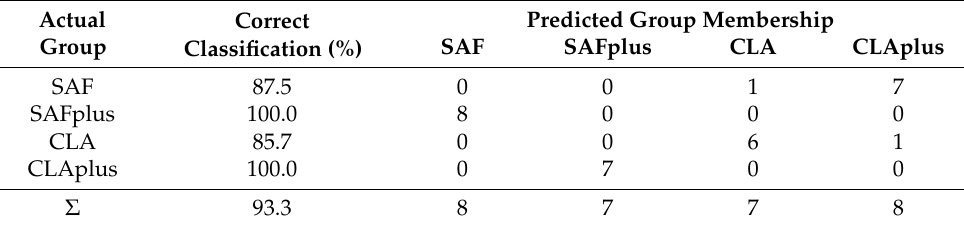
Table 6. Classification results of the LDA presenting the percentage of predicted group membership for actual groups.